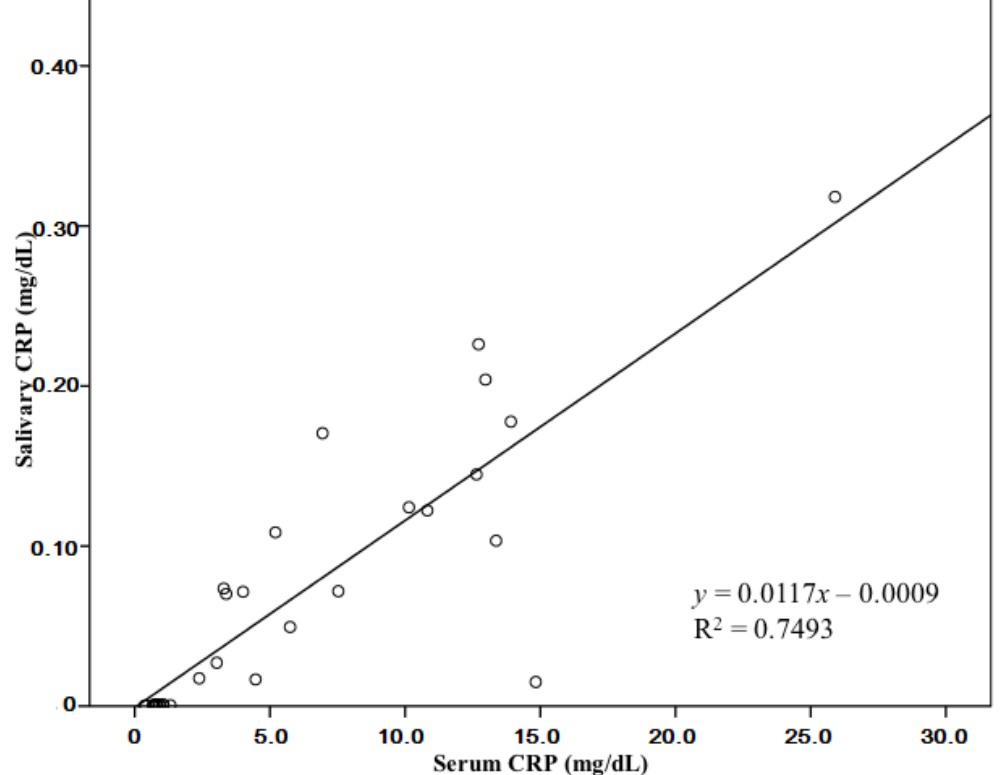
Figure 1. Correlation between C-reactive protein (CRP) levels in serum and saliva.